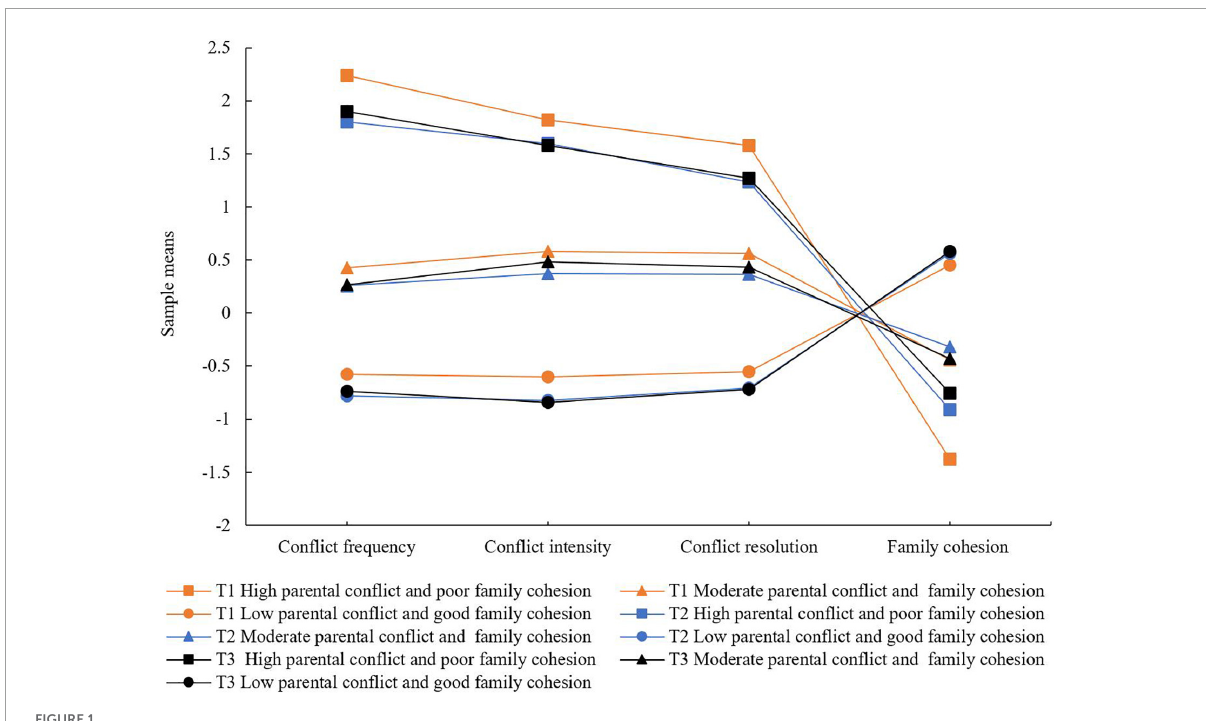
FIGURE1 The sample means of latent profiles for parental marital conflict and family cohesion at each time point. The y -axis represents the mean score of parental marital conflict and family cohesion. All the dimensions are listed on the x -axis.